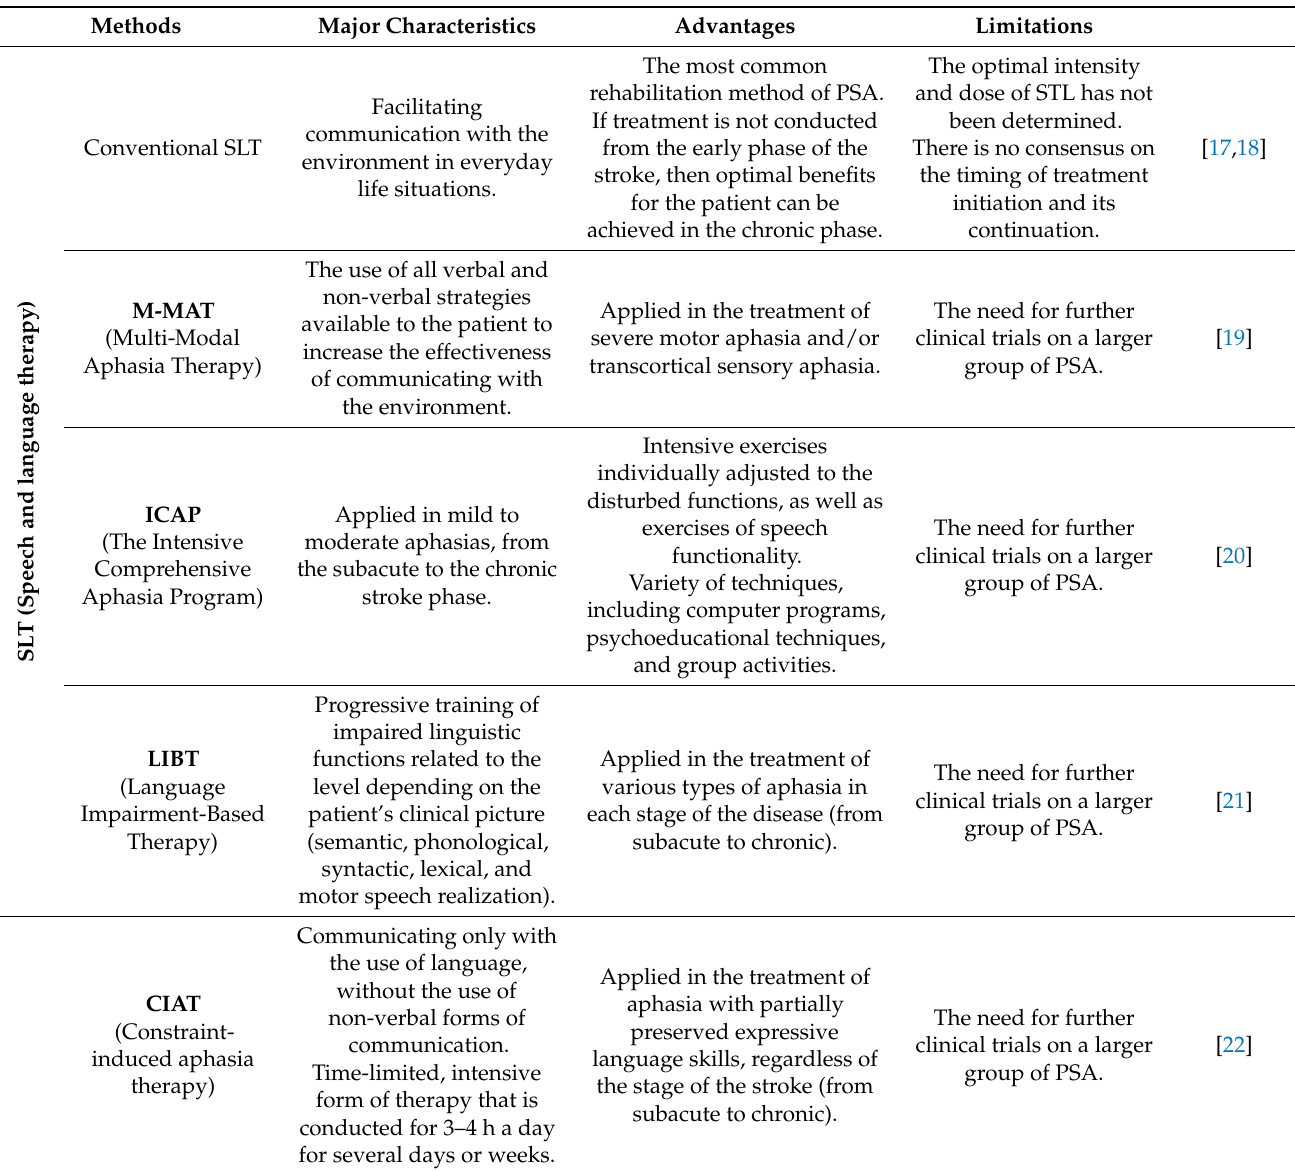
Table 2. The main and adjuvant therapies in post-stroke